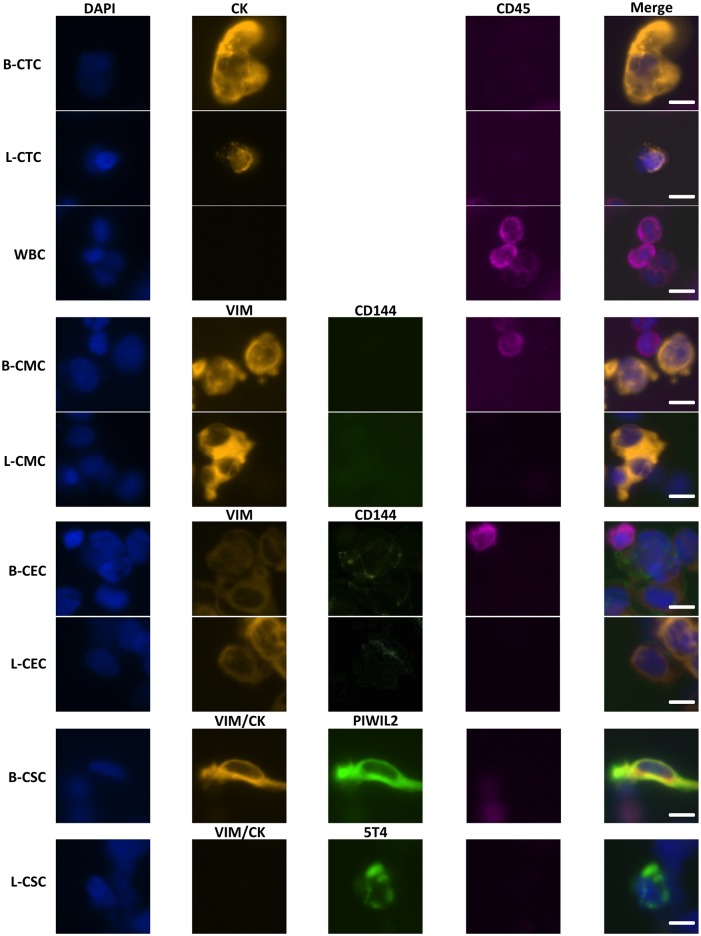
Immunocytochemistry staining of circulating rare cells.Representative images of circulating tumor cells (CTC), white blood cells (WBC), circulating mesenchymal cells (CMC), circulating endothelial cells (CEC), and putative circulating stem cells (CSC) in metastatic breast (B) and lung (L) cancer patients. The scale bar represents 8μM.